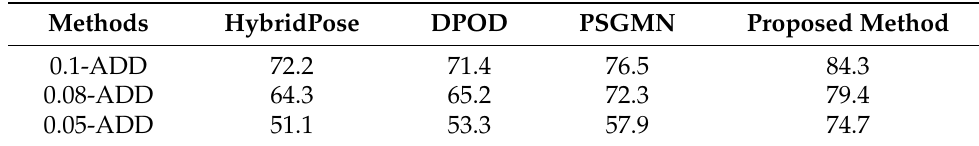
Table 2. Comparison of the proposed method with the other methods in terms of ADD metric.